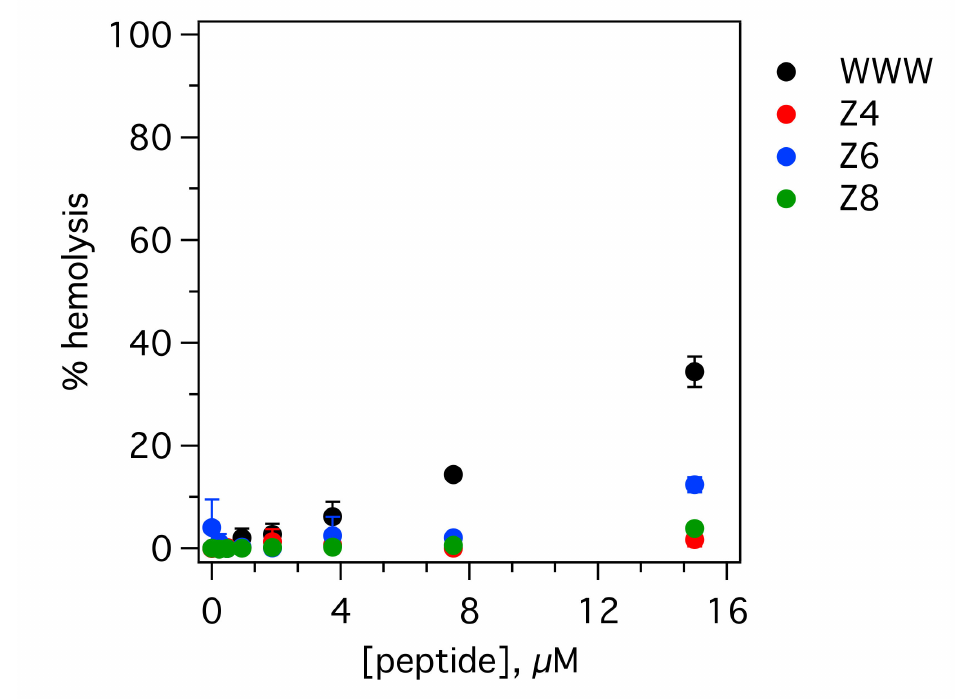
Figure 6. Hemolysis of red blood cells (RBCs) as measured by absorbance at 415 nm. The mammalian cell cytocompatibility of AzAla-substituted peptides was also tested using 3T3 mouse fibroblasts. After cells were incubated with peptides for 5 h, the metabolic activity of cells was assessed using a resazurin-based assay. The amount of living cells is determined based on the fluorescence of resorufin, the product of resazurin reduction by mitochondrial enzymes, which are only active if cells are actively respiring (Figure